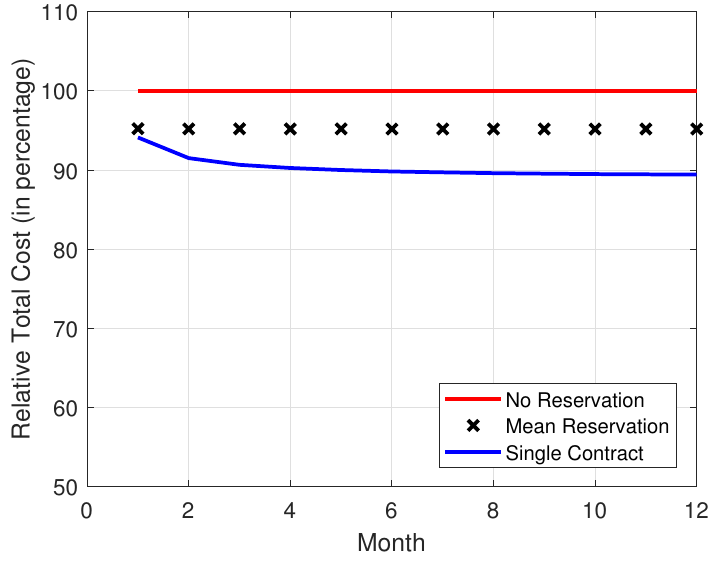
Figure 7. Relative total cost vs. month. The demand traffic is modeled as an exponential stochastic process with mean = 4000 VMs. Monthly cost (in